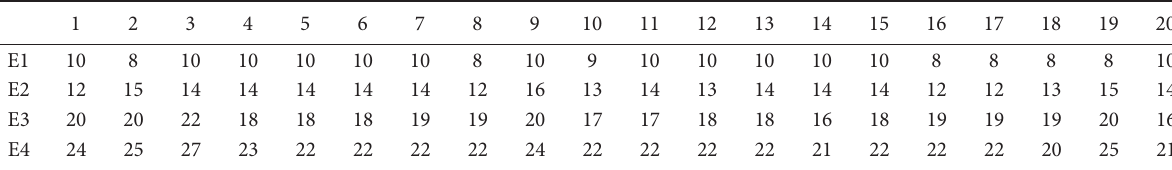
Table 3. Number of leaflets up to fourth eophyll in Aeschynomene scabra